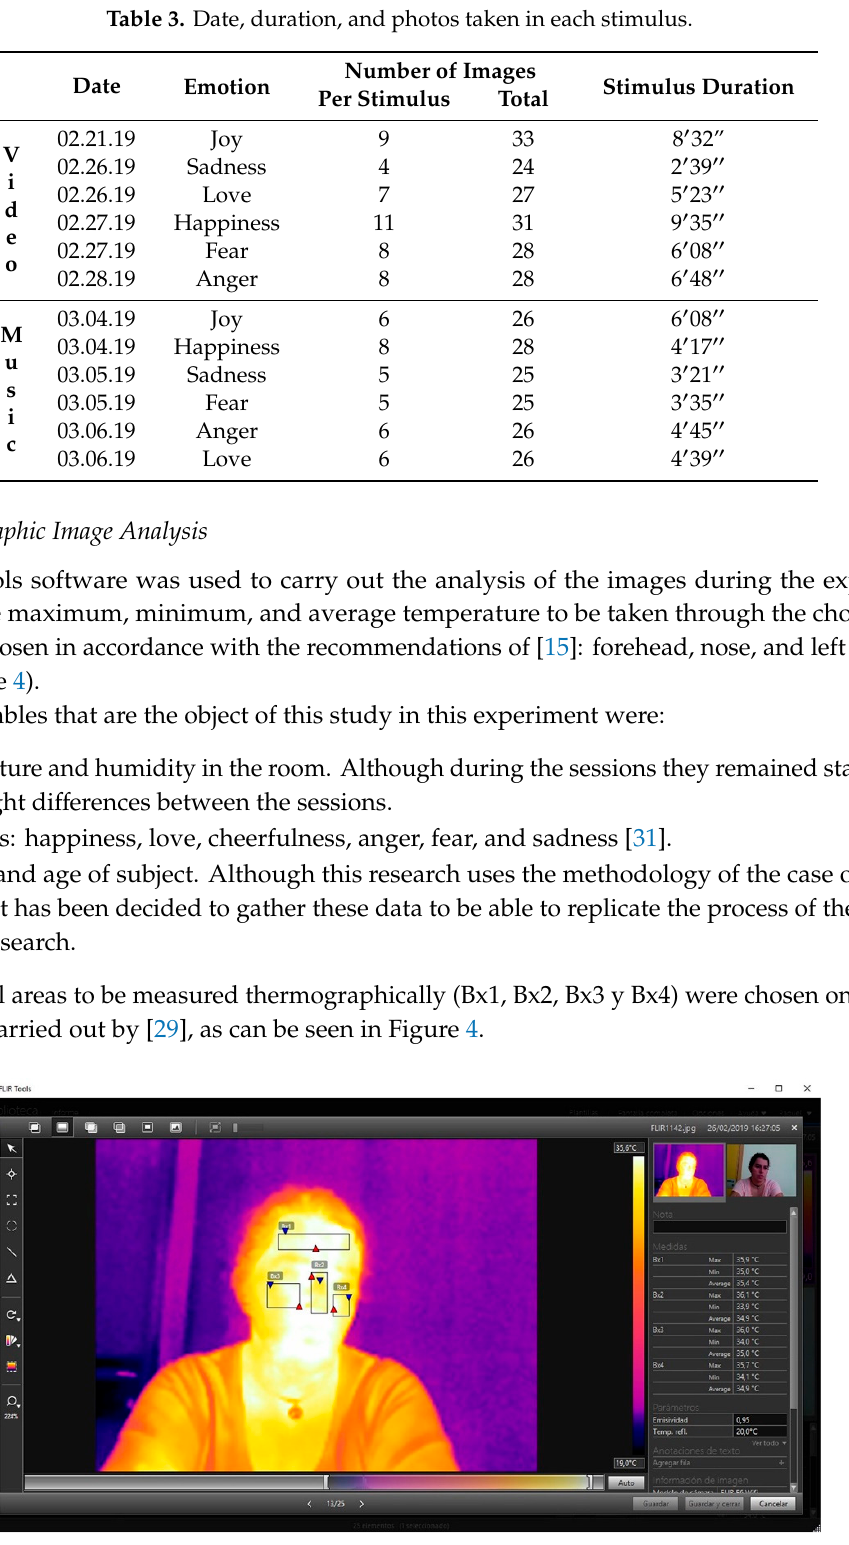
Figure 4. Individual image obtained during the sessions where it is possible to observe the facial areas measured with the temperature values calculated by the software.